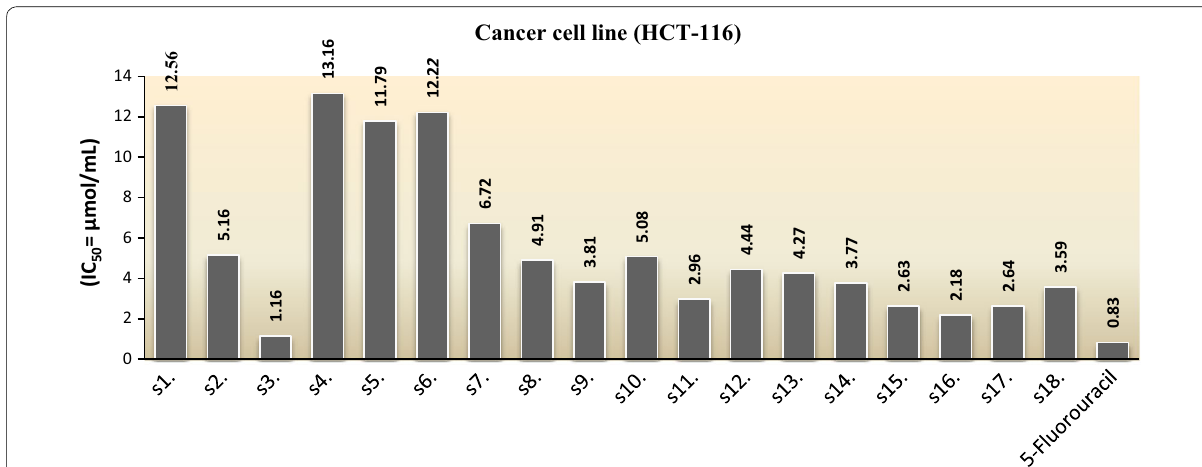
Fig. 3 Anticancer screening results of synthesized molecules against cancer cell